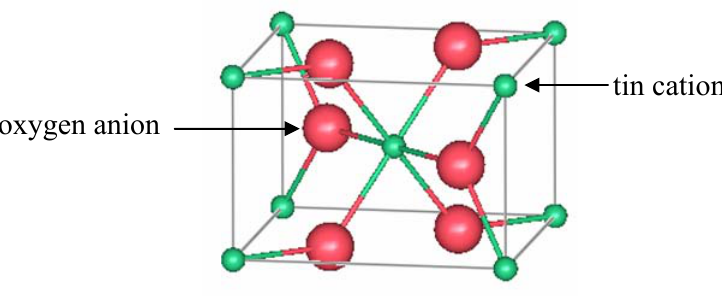
Figure 3. One unit cell of rutile SnO